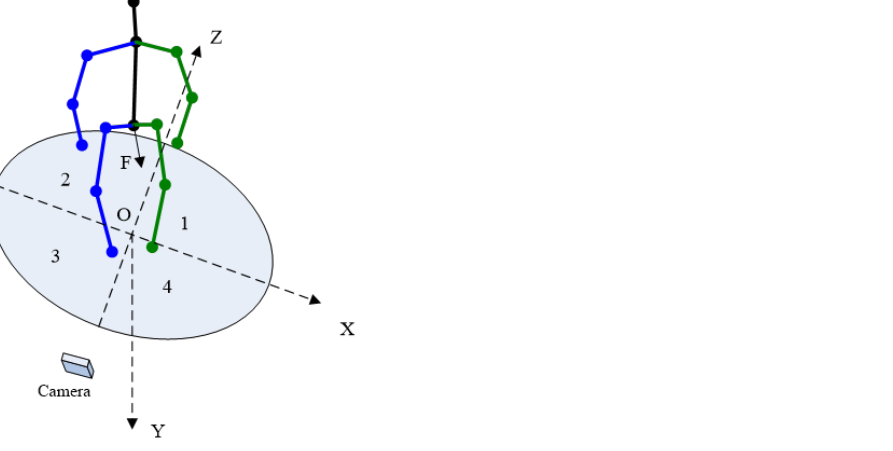
Figure 3. The orientation of the body in coordinate system. The number 1-4 denote the four quadrants of the XOZ plane.